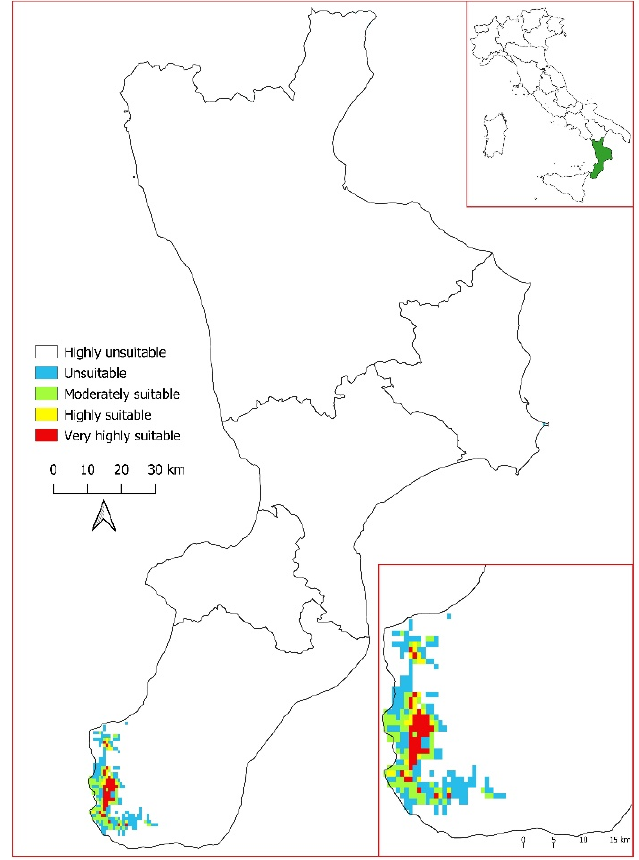
Figure 5. Prediction of the current potential distribution of Salvia ceratophylloides Ard. In white, highly unsuitable habitat ( ≤ 0.20); in blue, unsuitable (0.21–0.40); in green, moderately suitable (0.41–0.60); in yellow, highly suitable (0.61–0.80); in red, highly suitable ( ≥ 0.80). In the top left-hand corner, the Calabria region within the Italian territory is highlighted in green.